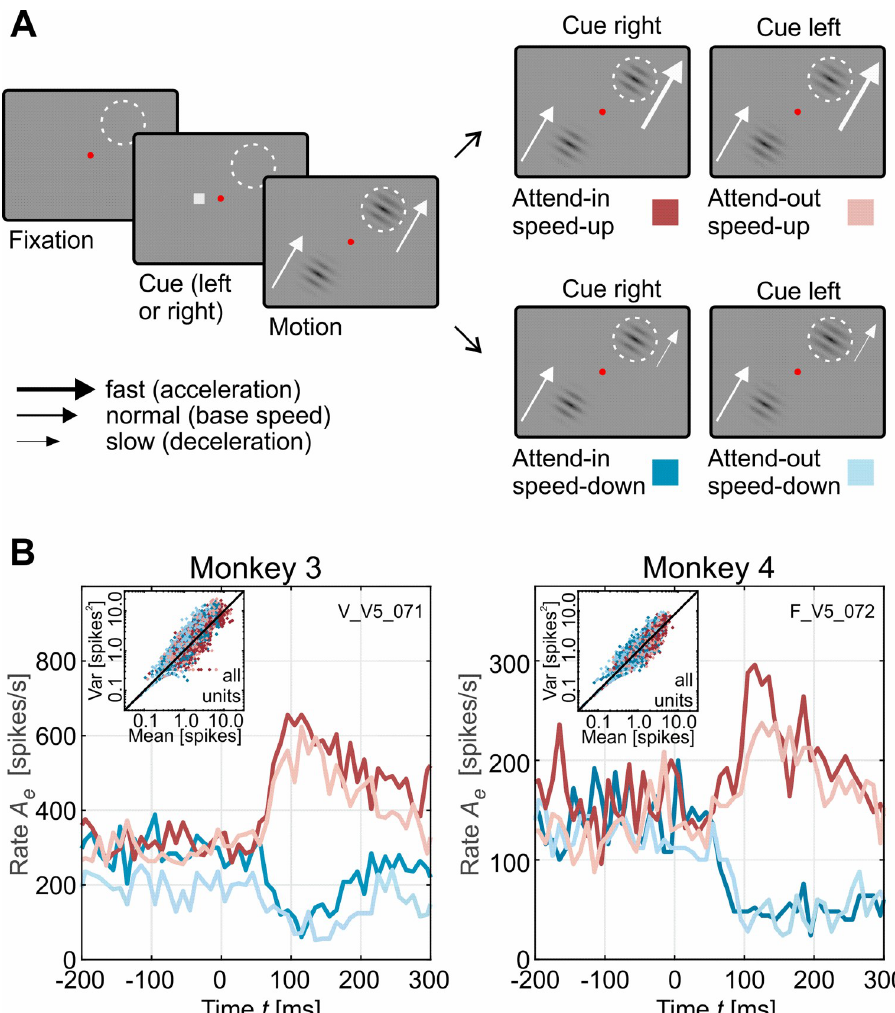
Fig 5. Experimental speed change detection paradigm and example PSTHs. (A) Monkeys were detecting positive and negative speed changes (presented block-wise) at pre-cued locations. Each trial started with a cue indicating the hemifield of the rewarded stimulus (small gray box, left or right of the central, red fixation spot). After monkeys properly fixated and pressed a lever, two moving gratings appeared, one of which was placed inside the RF of the recorded neuron (dashed white circle), while the other was placed in the opposite hemifield, mirrored across the fixation spot. Following a pseudo-randomized delay of 0.66 to 5.5 s, the RF-stimulus rapidly increased (top row) or decreased speed (bottom row). Any speed change of the stimulus in the uncued hemifield had to be ignored. Keeping fixation and releasing the lever within 750 ms after the speed change was rewarded with some drops of water or diluted grape juice. Depending on the cued stimulus location, the RF stimulus was either attended or non-attended, giving rise to four experimental conditions (right plots, color-coded). (B) PSTHs for two example multi-unit sites (one from each monkey), illustrating rapid firing rate adjustments in response to speed changes. Note that because negative speed changes result in a decrease of the firing rate, the stimulus-induced modulation of the firing rate is opposite to the attention-induced modulation before the change. Insets show spike counts and variances assessed in time intervals of 25 ms from -400 ms to +200 ms relative to stimulus change for all units. Color coding of the different attentional conditions is indicated in panel